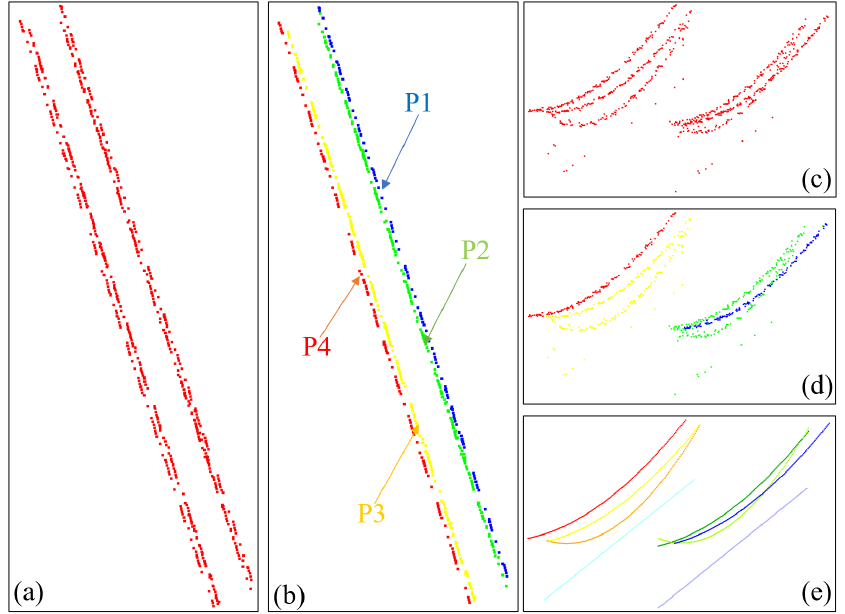
Figure 19. Wire individualization and reconstruction. ( a ) wire points distribution on the XOY plane; ( b ) wire individualization based on the XOY plane; ( c ) side view of ( a ); ( d ) side view of ( b ); ( e ) wire reconstruction